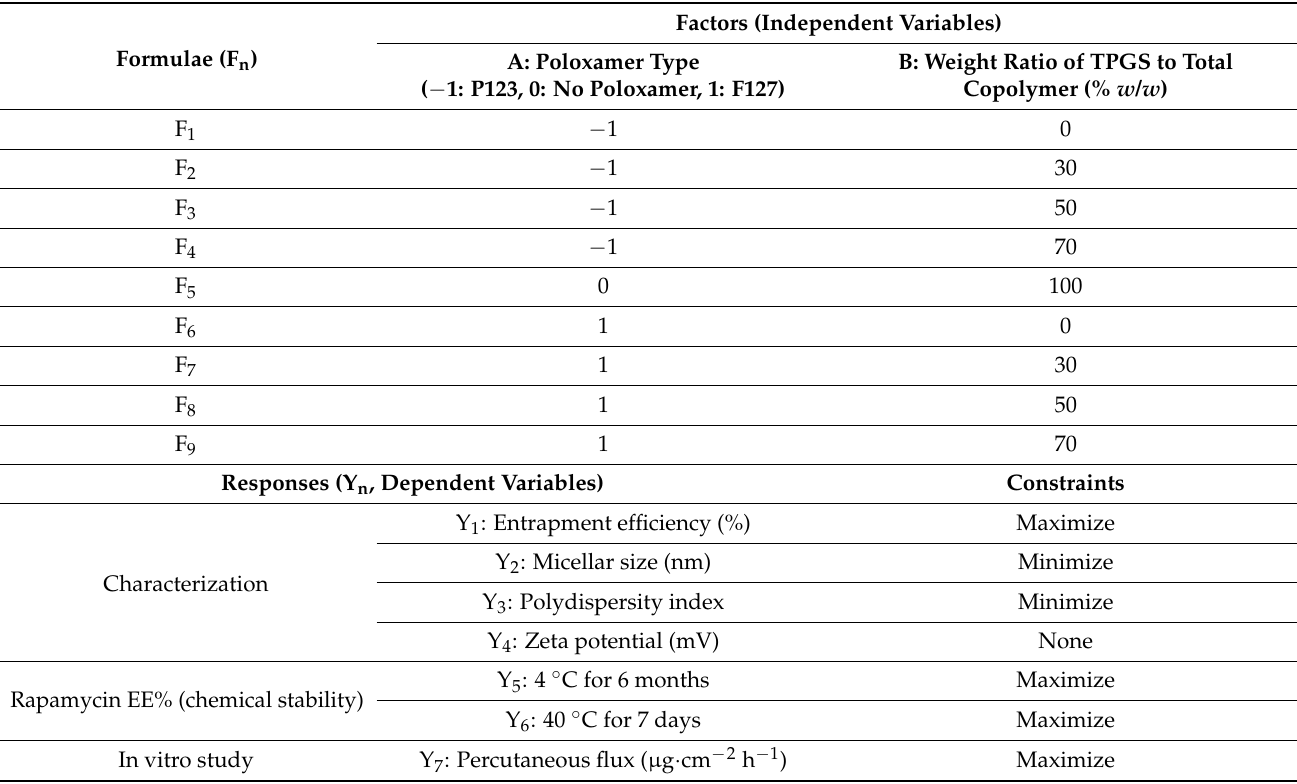
Table 1. Formulae, independent and dependent variables investigated in the full factorial design for rapamycin polymeric micelle preparation and the constraints applied for